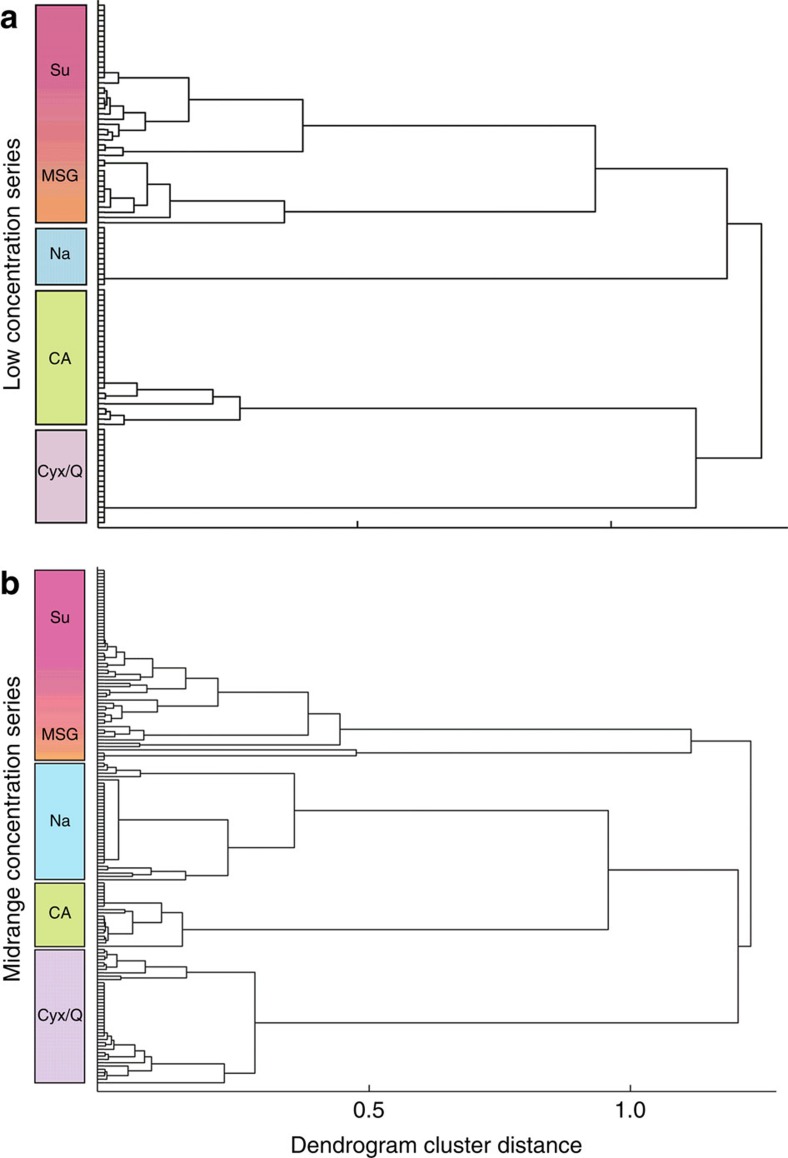
Dendrograms of taste-evoked responses from geniculate ganglion neurons show clustering into sweet, umami, salty, sour and bitter.Five prototypic taste solutions were sequentially perfused over the tongue and palate and responses recorded (see Fig. 2d). Two ranges of stimulus concentrations were compared, (a) low (<EC50) and (b) mid-range (∼1.5 to 2 × EC50) as described in the text. Five main clusters are evident: sweet (Su, sucrose); umami (MSG, monosodium glutamate plus IMP); salty (Na, NaCl); sour (CA, citric acid); and bitter (Cyx, cycloheximide; Q, quinine·HCl). Data represent 101 neurons from 12 mice (a), and 155 neurons from 9 mice (b). Taste stimuli, low concentrations (a): 100 mM sucrose; 60 mM NaCl; 3 mM citric acid; mixture of 0.6 μM cycloheximide with 0 or 0.1 mM quinine; 60 mM monosodium glutamate with 1 mM IMP. Taste stimuli, mid-range concentrations (b): 300 mM sucrose; 250 mM NaCl; 10 mM citric acid; mixture of 1 μM cycloheximide with 0.3 mM quinine; 100 mM monosodium glutamate with 1 mM IMP.